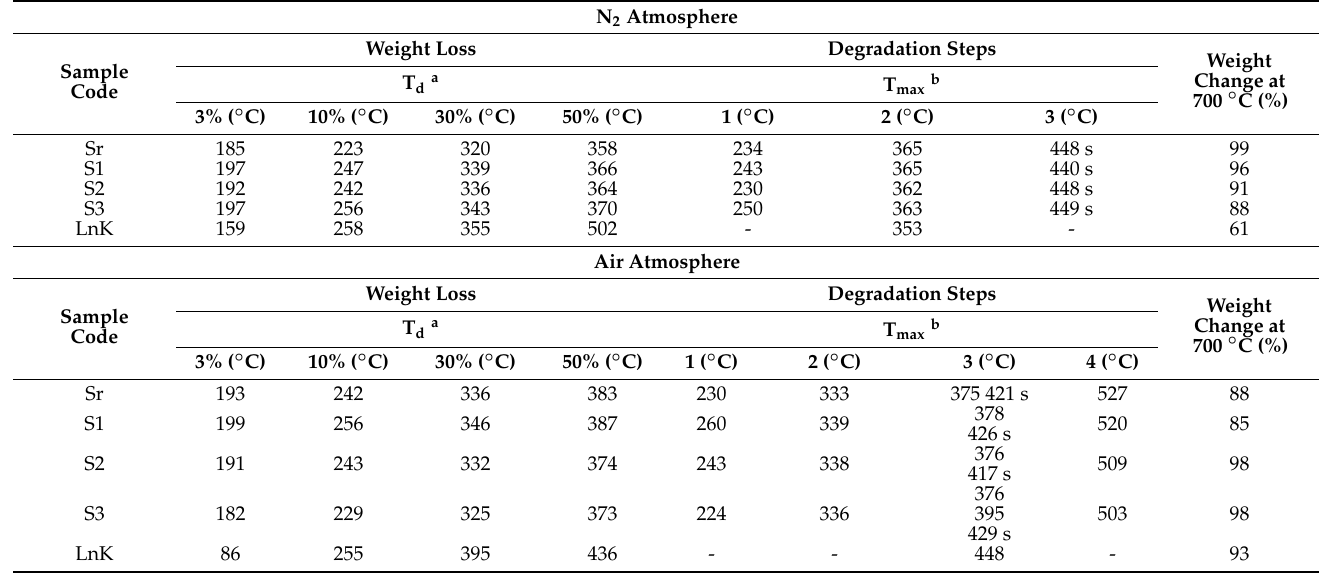
Table 1. TGA data of ELO and LnK-based products (N 2 and